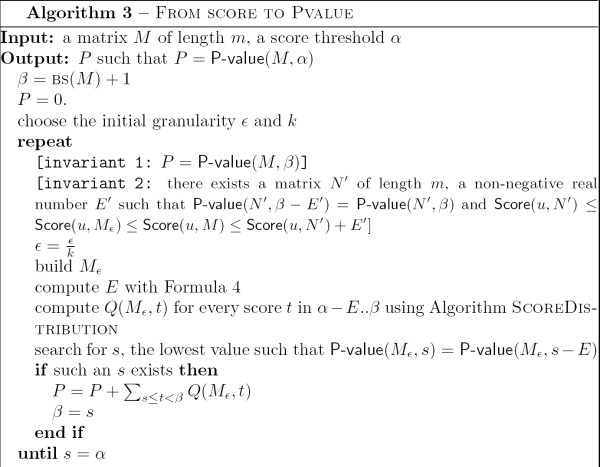
Algorithm From Score to P-value.